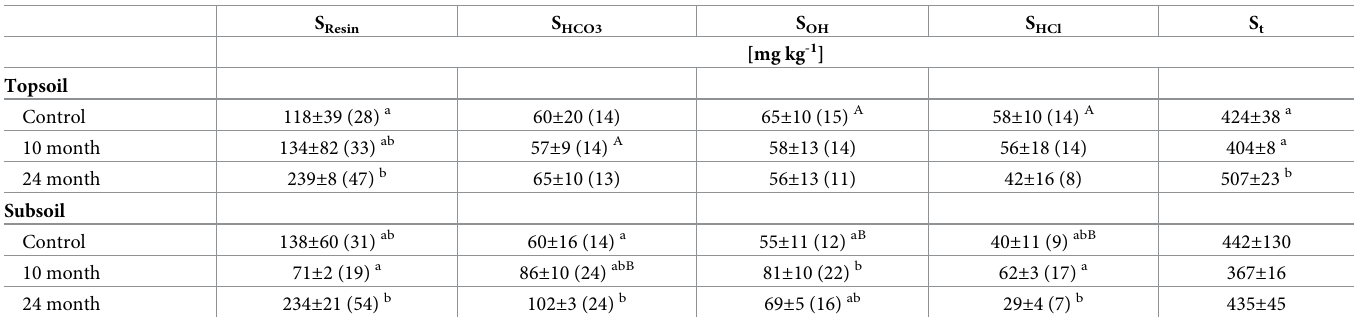
Table 5. Concentrations (mg kg -1 ) ± standard deviation of sequentially extracted sulfur (S) fractions and proportions of total S (S t ) in parenthesis of the control without clear-cut, 10, and 24 month after clear-cut. Different lowercase letters indicate significant ( P < 0 . 05 ;n = 3) differences with time for top- or subsoil samples, respectively, whereas different uppercase letters indicate significant differences of top- and subsoil samples at the respective sampling